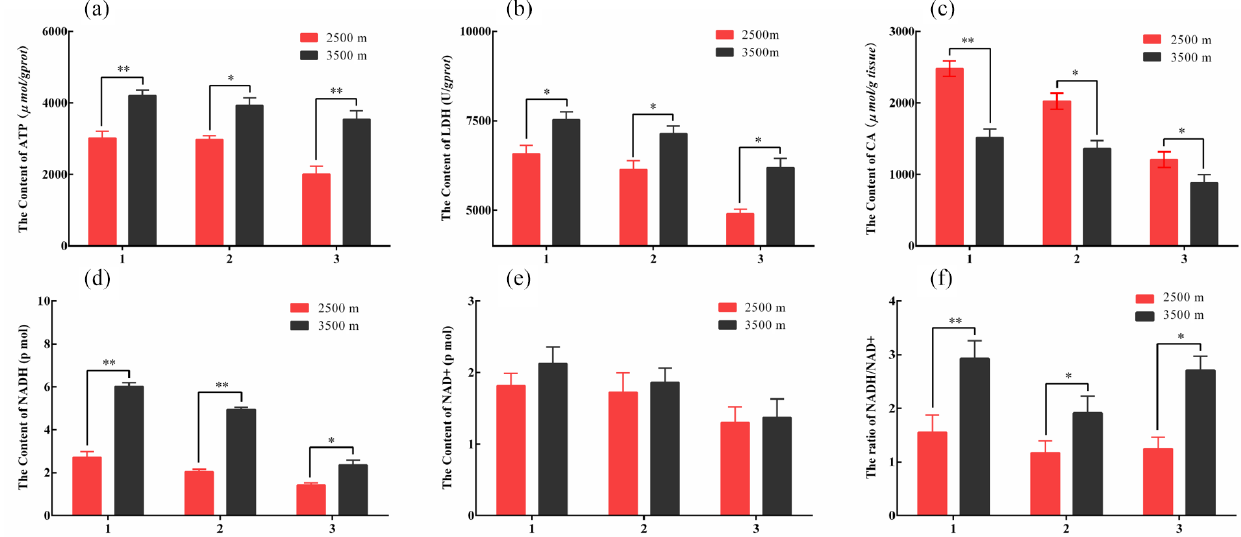
Figure 2. The contents of key glucose metabolism enzyme in various tissues obtained from yak from different altitudes. Note that ho- mogenates from the heart (1), lung (2), and longissimus dorsi (3) tissues were analyzed contents of ATP (a) , LDH (b) , CA (c) , NADH (d) , and NAD + (e) . The ratio of NADH/NAD + (f) also was analyzed. The bars represent the mean ± SEM from three independent biological replicates, each performed with three technical replicates. Asterisks denote significant differences: * P < 0 . 05; ** P < 0 . 01